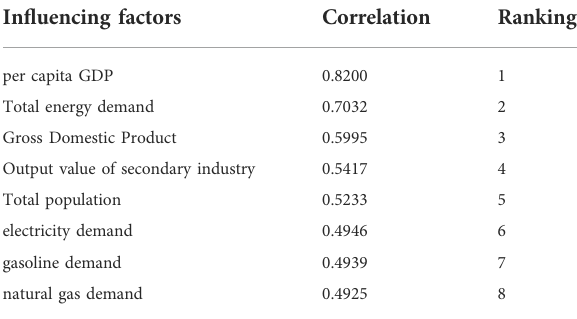
TABLE 1 The correlation degree between various in fl uencing factors and coal